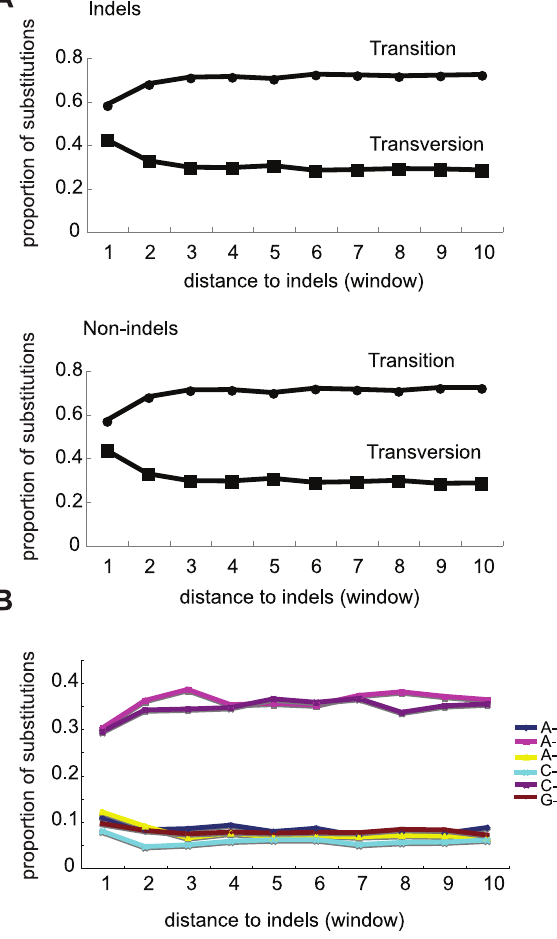
Figure 5. Transversion mutations comprise a larger proportion of all mutations close to indels. Transition mutations are usually the most common type of mutations, as indicated by their prevalence in the regions of sequence outside the influence of indel/region- associated mutagenicity. (A) Comparison of indel and non-indel haplotypes reveals that both exhibit the same increase in transversion substitutions with increasing proximity to the indel site. The difference between the number of transitions close to the indel (window 1) was found to be significantly lower than in sequence further from the indel (window 4) (two-sample Kolmogorov-Smirnov test, p , 0.0001). (B) The proportions of each type of transversion (bottom lines) and transition (top lines) as a function of indel position. Transitions and transversions given in the legend represent substitutions in both directions (i.e., A–G includes both A–G and G–A proposal that heterzygosity/heterogenosity causes the indel ‘‘bump.’’ An alternative explanation is that the indel-associated bump in D may be due to the indel-causing event resulting in multiple nucleotide changes. This possibility is not implausible considering the spectrum of mutations in baker’s yeast. Lang and Murray [30] found that in 63% of instances where two mutations occurred at the same time one was an indel and the other a nucleotide substitution; yet indels constituted only 6.67% of all mutations observed in that study. Whichever explanation is correct, it is evident that the indel effect is transient and that it is the surrounding sequence that is associated with the accruement of substitutions over evolutionary time scales.